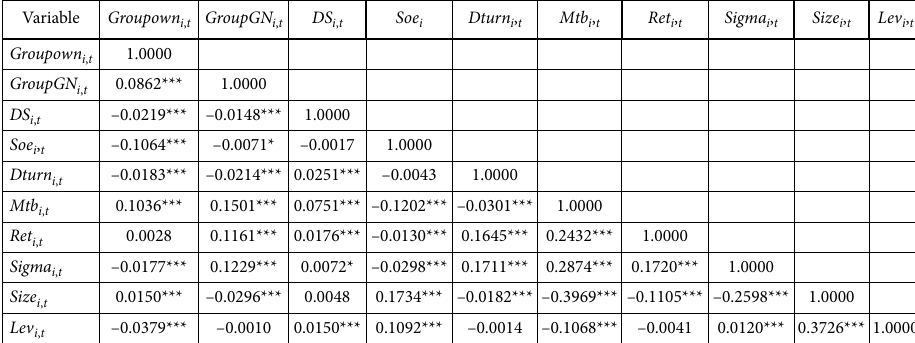
Table 5. Pearson correlation coefficients of the